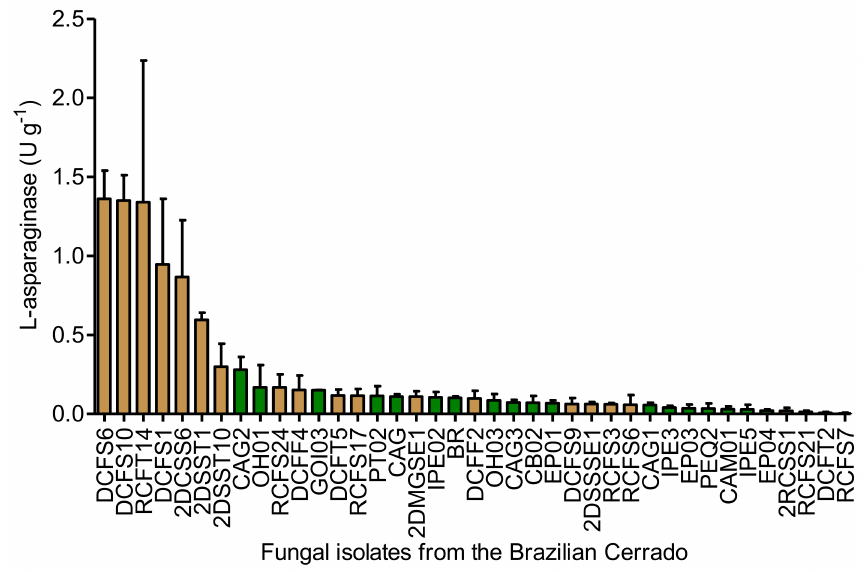
Figure 2. Distribution of L -asparaginase activity quantified in the cells of 39 fungal isolates from the Brazilian Savanna grown under submerged fermentation. Results are presented as mean ± standard deviation of enzyme activity. Brown bar: soil isolates; green bar: endophytes.